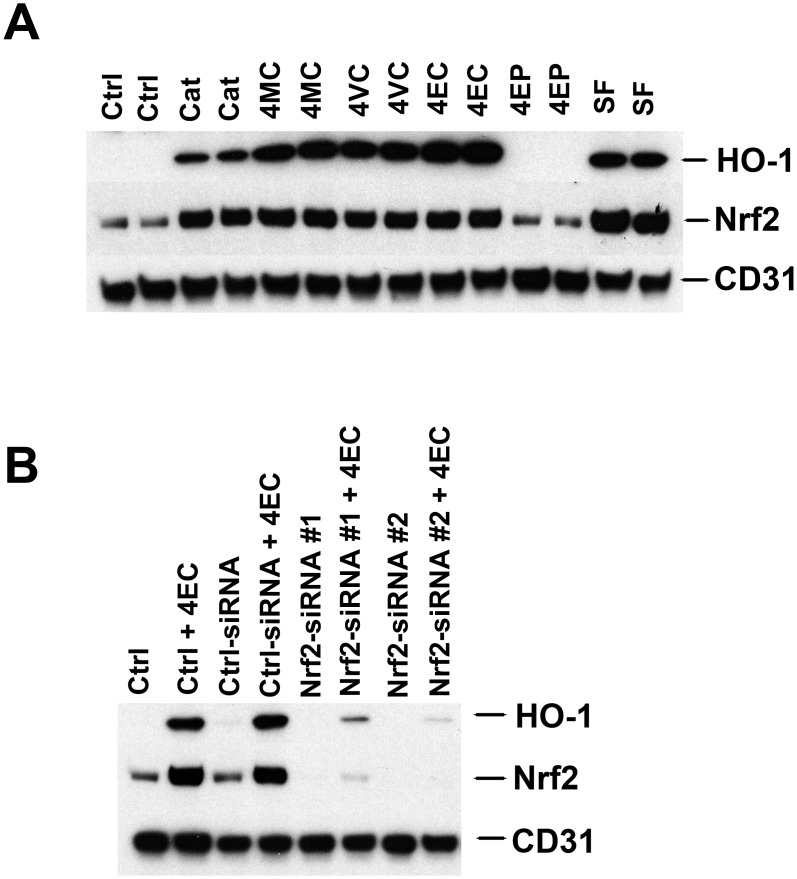
Induction of HO-1 protein expression by catechol, akyl catechols, and sulforaphane; inhibition by Nrf2 siRNAs.(A) Western blotting of human microvascular endothelial cells, harvested 24 hours after adding compounds. Ctrl = control, Cat = catechol, 4MC = 4-methylcatechol, 4VC = 4-vinylcatechol, 4EC = 4- ethylcatechol, 4EP = 4-ethylphenol, SF = sulforaphane. Catechol, 4MC, 4VC, 4EC, and 4EP were each added to a final concentration of 30 μM; sulforaphane was added to a final concentration of 20 μM that is the maximum tolerated dose (higher doses cause cell death). CD31 = protein loading control. (B) Western blotting of human umbilical vein endothelial cells, either untransfected (Ctrl) or transfected with control siRNA (ctrl-siRNA) or Nrf2 siRNAs (Nrf2-siRNA#1; Nrf2-siRNA#2)) and harvested 24 hours after addition of 30 μM 4EC (+4EC), where indicated. CD31 = protein loading control.